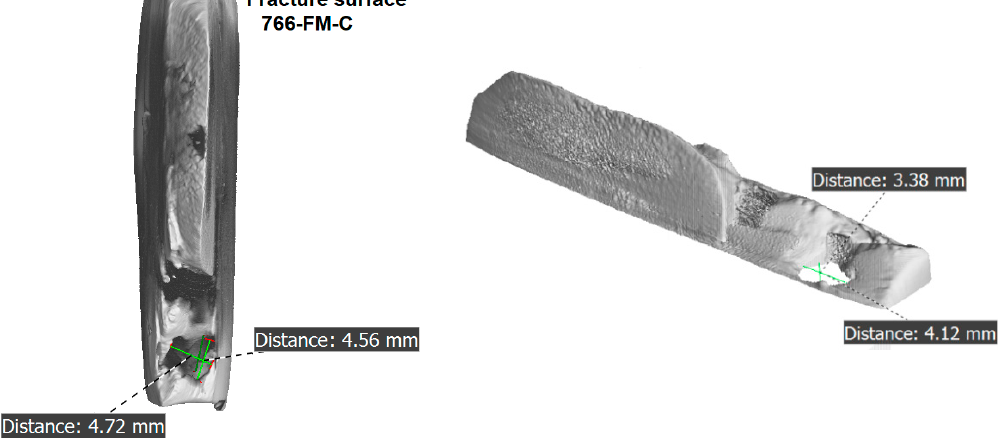
Figure 19. Fracture surface reconstruction of the specimen 766-FM-C, where a large discontinuity caused a very low fatigue strength.